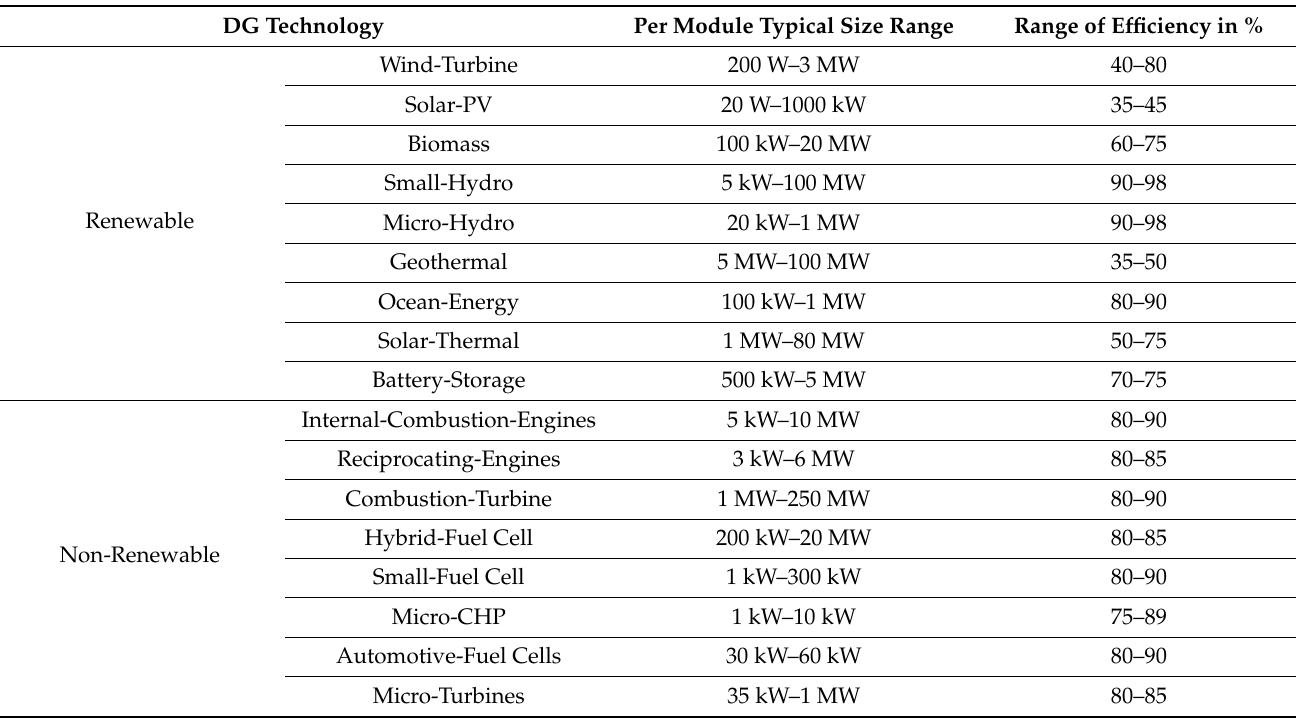
Table 2. Various DG technology with their per module specification and efficiency range.